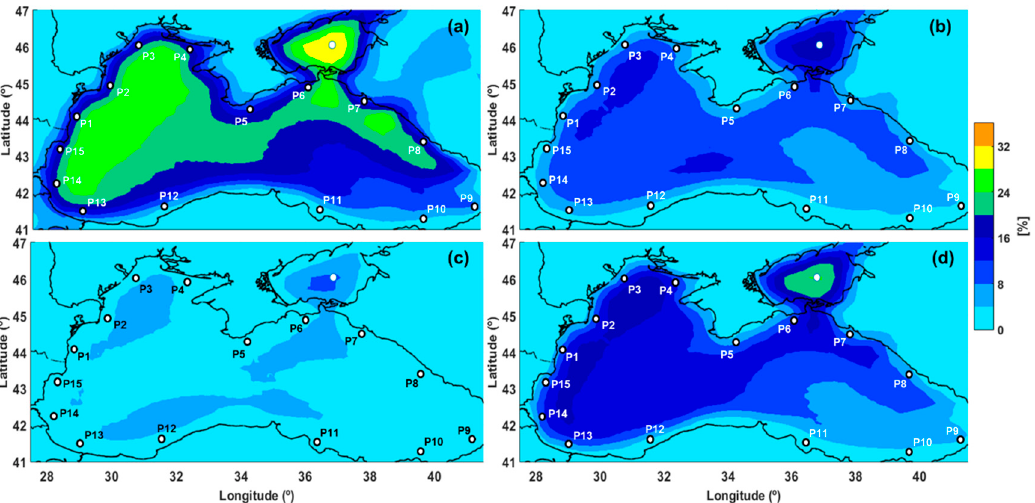
Figure 7. Seasonal distribution of the U 10 parameter higher than 10 m/s considering the entire 30-year period (1987–2016) of NCEP wind data, where: ( a ) winter; ( b ) spring; ( c ) summer; ( d ) autumn.